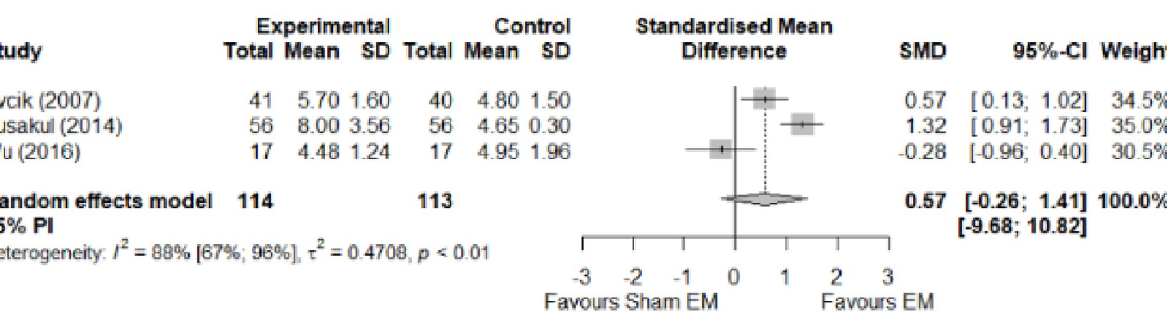
Fig 12. Analysis—Electrophysical modalities versus placebo (pinch strength).